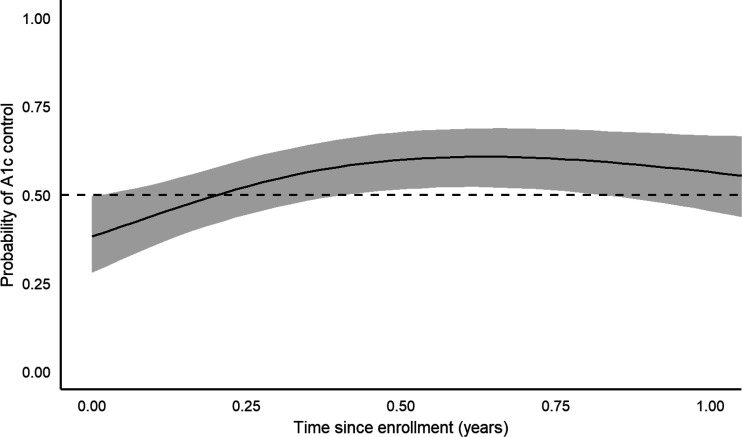
Estimated Probability of Hemoglobin A1c Control (≤8%) Over Time After Enrollment in Rural Diabetes Care Program, Guatemala